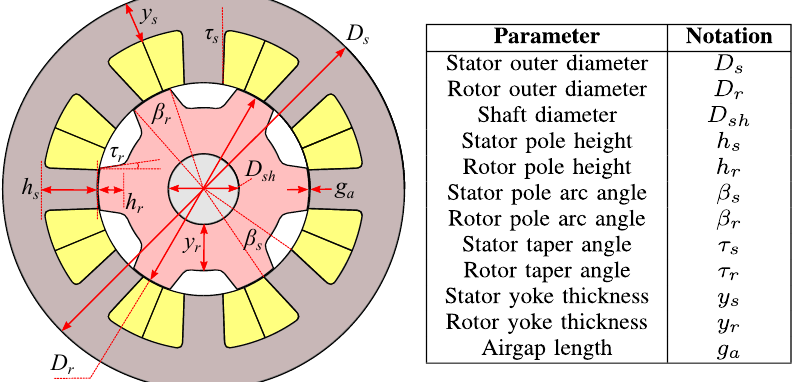
Figure 2. Terminology for typical SRM